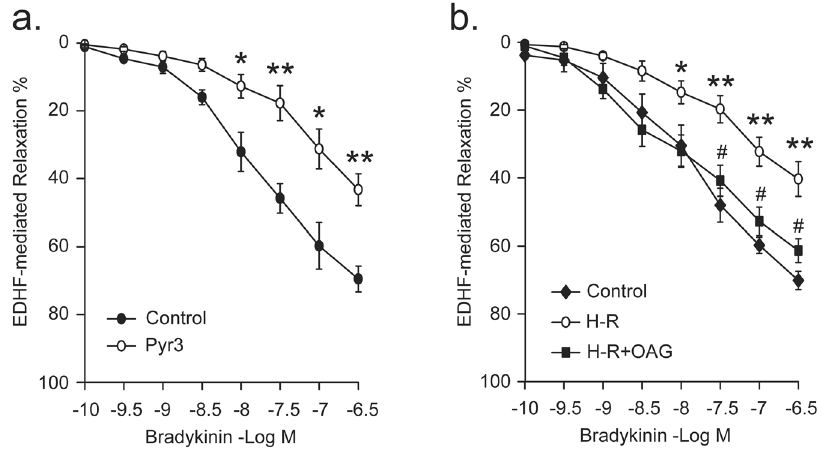
Figure 5. TRPC3 channels play an important role in EDHF-mediated relaxation in porcine small coronary arteries ( a , n = 8 in each group). H-R exposure impairs the EDHF-mediated vasorelaxation and activation of TRPC3 preserves the EDHF-type response under H-R condition ( b , n = 8 in each group). The EDHF-response was induced by bradykinin in the presence of indomethacin, N G -nitro-L-arginine, and oxyhemoglobin. * p < 0.05, ** p < 0.01 vs. control; # p < 0.05, ## p < 0.01 vs. H-R, unpaired t test ( a ), one-way ANOVA and Scheffe post-hoc test ( b ). Pyr3: TRPC3 selective blocker. OAG: TRPC3/6/7